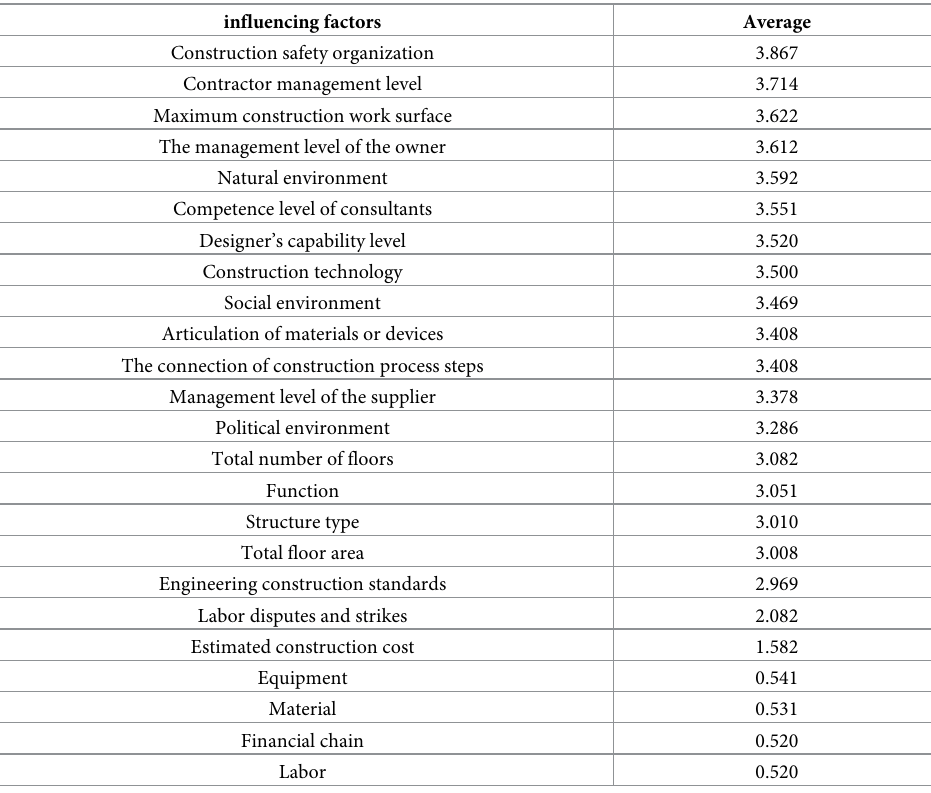
Table 2. The average value of the